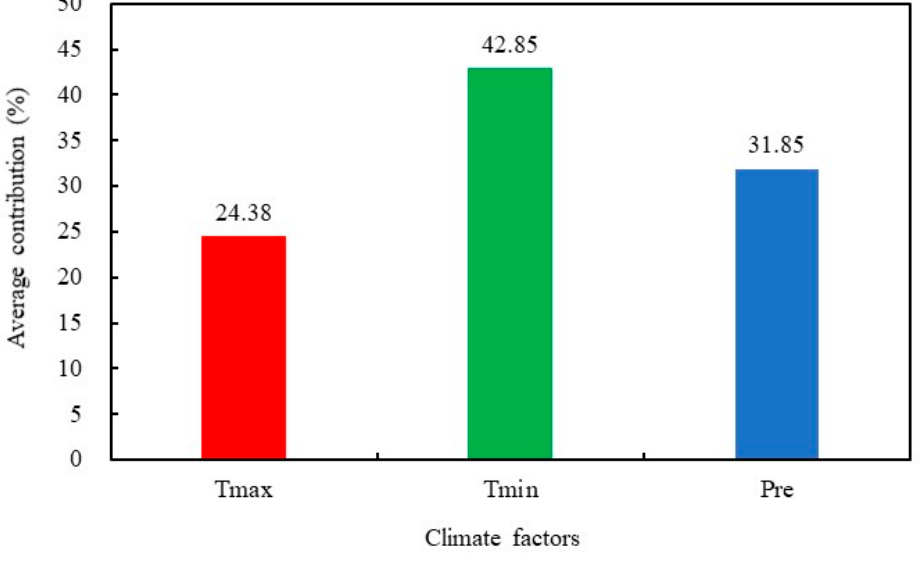
Figure 9. The average relative contributions of Tmax, Tmin, and Pre to FVC variations in the subtropical region.